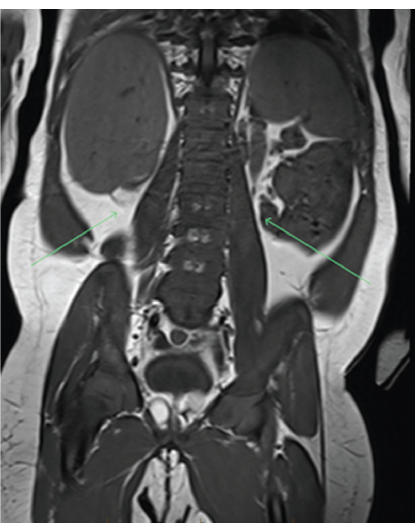
Figure 3: Coronal T1-weighted MRI image showing absence of renal tissue